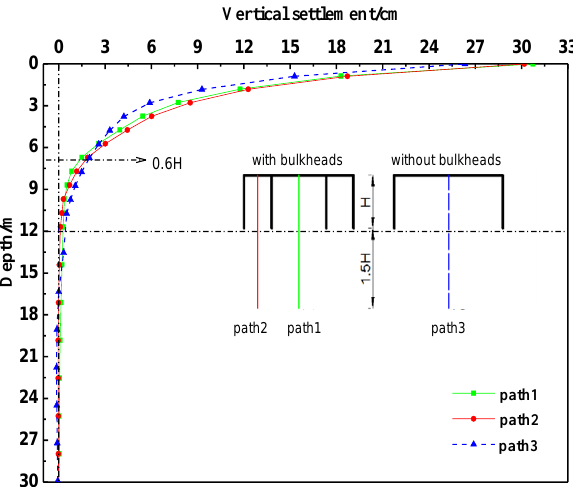
Figure 7. Variation in vertical settlements with soil depth along different paths.